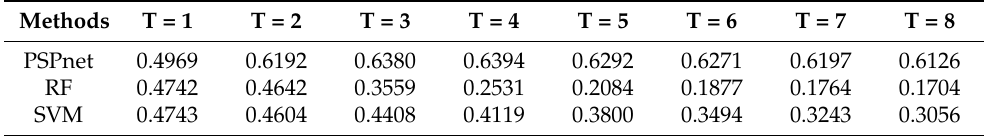
Table A1. The IoU of sample size S = 35 varies with the threshold level